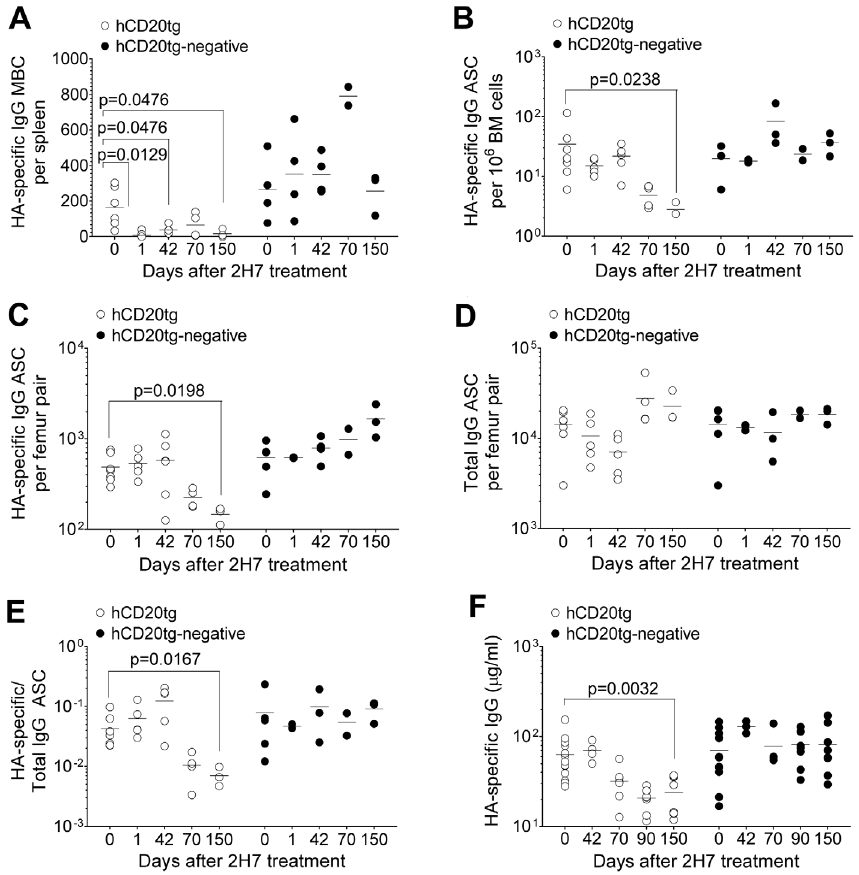
Figure 6. Eventual loss of HA-specific ASCs and HA-specific serum IgG after depletion of HA-specific MBC. 8–10 wk old female hCD20tg and hCD20tg-negative littermates were infected with Influenza A/PR/8/34, and treated with anti-hCD20 mAbs as described in the Materials N ) just before treatment and 1 day, 42 days, 70 days and and Methods. A. HA-specific IgG MBCs in spleens from hCD20tg ( # ) and hCD20tg-negative ( 150 days post-treatment [hCD20tg: n=5(d0), 5(d1), 3(d42) and 3(d150); hCD20tg-negative littermates: n=4(d0), 2(d1), 2(d42) and 3(d150)]. The data are pooled from 3 independent experiments. B–D. Femur pairs were obtained from mice and HA-specific and total IgG bone marrow ASCs were N ) mice prior to treatment and 1 day, 42 days, 70 days and 150 days post-treatment. quantified using ELISpot in hCD20tg ( # ) and hCD20tg-negative ( [hCD20tg: n=7(d0), 5(d1), 5(d42) and 3(d150); hCD20tg-negative littermates: n=5(d0), 2(d1), 2(d42) and 3(d150)]. The graphs show number of HA- specific ASC B, per 10 6 bone marrow cells and C, per femur pair; D, number of total IgG ASC per femur pair; and E, numbers of HA-specific IgG ASC expressed as a ratio to total IgG ASC. The data are pooled from 3 independent experiments. F. Serum was obtained and HA-specific serum IgG were N ) just before treatment, and 42, 70, 90 and 150 days post-treatment by ELISA [hCD20tg: n=13(d0), quantified in hCD20tg ( # ) and hCD20tg-negative ( 4(d42), 8(d90) and 8(d150); hCD20tg-negative littermates: n=13(d0), 3(d42), 8(d90) and 8(d150)]. The data were obtained from 2 experiments. In figures A–F , error bars indicate the median 6 error and statistical values were calculated using a two-tailed Mann-Whitney test. Non-significant values (P . 0.05) are not indicated on the graphs.